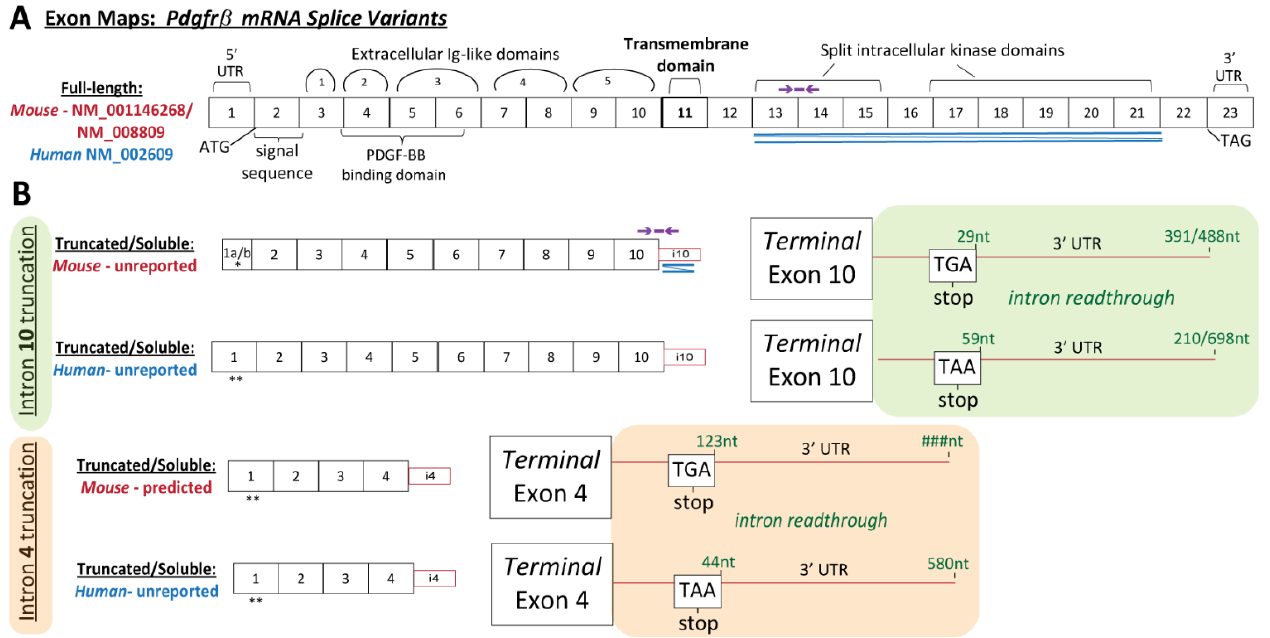
Figure 2. Exon Maps of Full-Length and Truncated Pdgfr β mRNA Transcripts were Constructed Based on Known and RLM-RACE-Generated Sequences. ( A ) Full-length Pdgfr β mRNA exon map based on murine (red accession number) and human (blue accession number) sequences with various regions labeled: signal sequence, PDGF-BB binding domain, five extracellular Ig-like domains, the transmembrane domain, and split intracellular kinase domains. Double blue lines indicate the region used to design RNA-Scope ® probes for in situ transcript detection. Purple line and arrows indicate the approximate region corresponding to qRT-PCR probes for relative quantitation of mouse full-length Pdgfr β transcripts. ( B ) Pdgfr β mRNA exon maps for soluble isoforms truncated at intron 10 (green background) or intron 4 (orange background) from both mouse and human. Double blue lines indicate the region used to design RNA-Scope ® probes for in situ transcript detection; 3 ′ UTR intron “read-through regions are shown corresponding to each truncation location and species. Purple line and arrows indicate the region used to design custom qRT-PCR probes for relative quantitation of i10 mouse sPdgfr β transcripts. Single asterisk (*) indicates an established 5 ′ sequence, while double asterisk (**) indicates 5 ′ sequences that are currently unresolved for these variants.